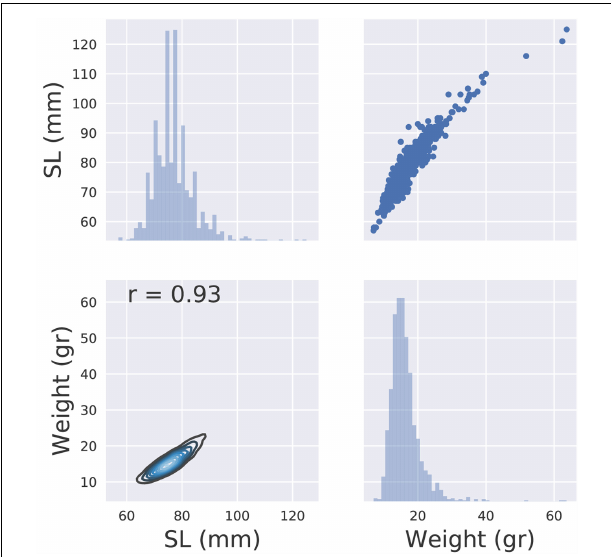
FIGURE 1 | Descriptive statistics of the phenotypic data (weight, length).